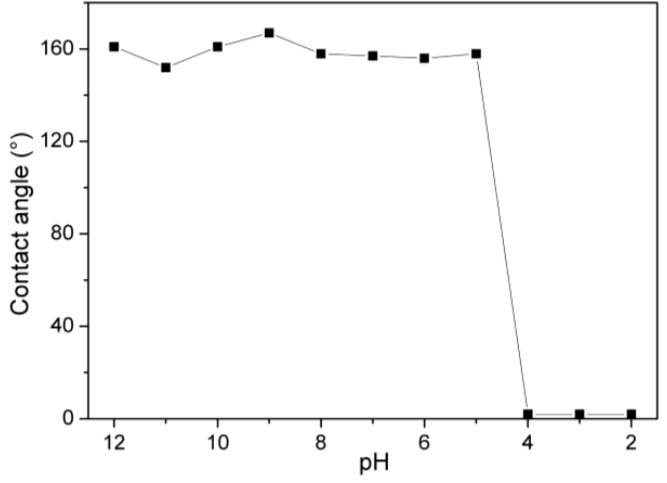
Figure 8. Contact angles (CA) of 1, 2-dichloroethane on PVDF-F127-P (MMA-AA) membrane surface as a function of the pH value.